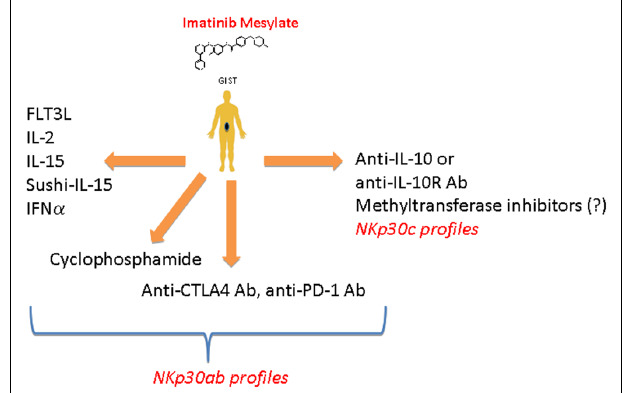
FIGURE 2 |Therapeutic strategies that could increase the functions of NK cells in patients with GIST. NK cells of patients with high expression of NKp30a and/or NKp30b isoforms could be reinvigorated using treatments that are know to favor either direct activation (IL-2, IFN- α , IL-15, sushi-IL-15) or indirect activation (FLT3, cyclophosphamide) of NK cells along with imatinib mesylate treatment. Since Balachandran etal. (2011) have shown that CD8 + T cells could favor tumor regression it is conceivable to use drugs that will favor CD8T cell activation (anti-PD1 or anti-CTLA4). In patients harboring the wrong NKp30 profile (high expression of NKp30c isoform) blocking IL-10 or IL-10 receptor (IL-10R) or using agent that could modify the NKp30 profile toward the NKp30ab profile (methyltransferase inhibitors?) might restore the NKp30-dependant NK cells function, thus favoring the control of tumor growth and/or